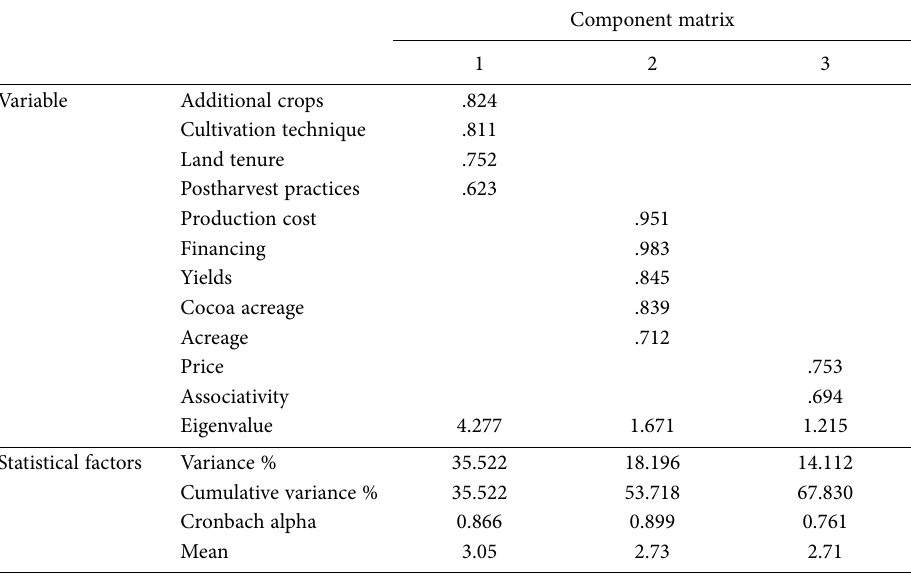
Table 7. Matrix of extracted components from PCA analysis of CCN-51 cocoa producers.